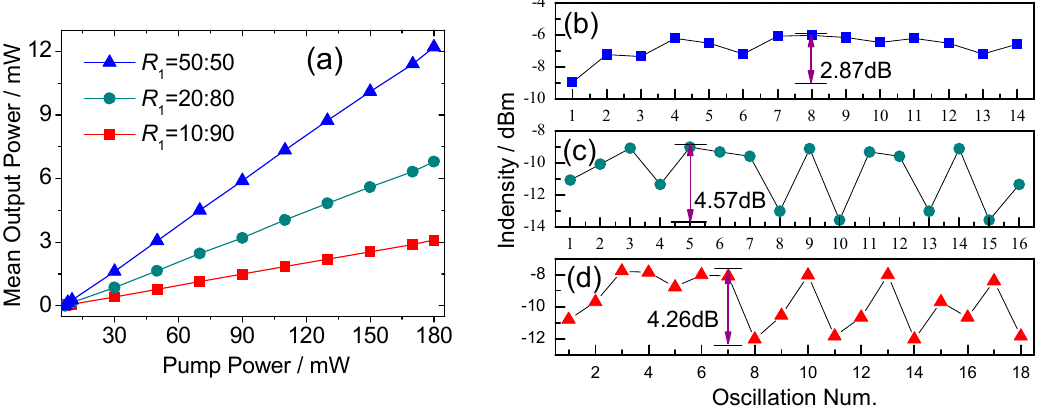
Figure 4. The outputs of MWEDFL with different ratios of C1, ( a ) mean output power by varying pump power, and the intensity of each oscillation at P = 180 mW when ( b ) R 1 = 50/50, ( c ) R 1 = 20/80, ( d ) R 1 = 10/ 90.